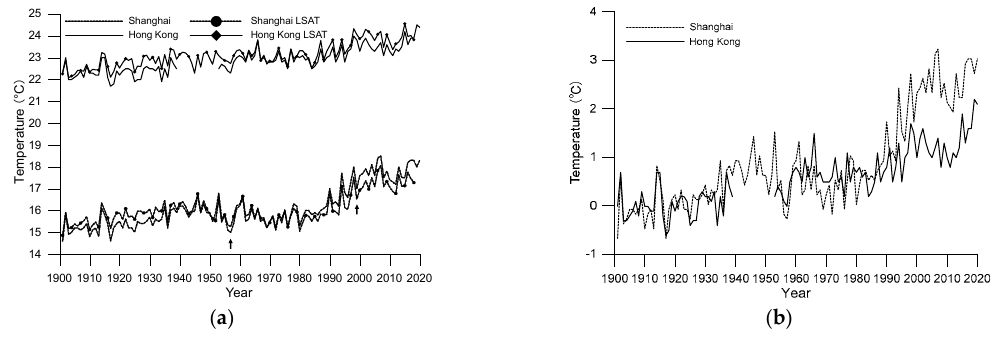
Figure 2. Annual average air temperature from 1901 to 2020 for the Shanghai and Hong Kong observatories (( a ) original observations; ( b ) anomalies to the average values during 1901-1930).